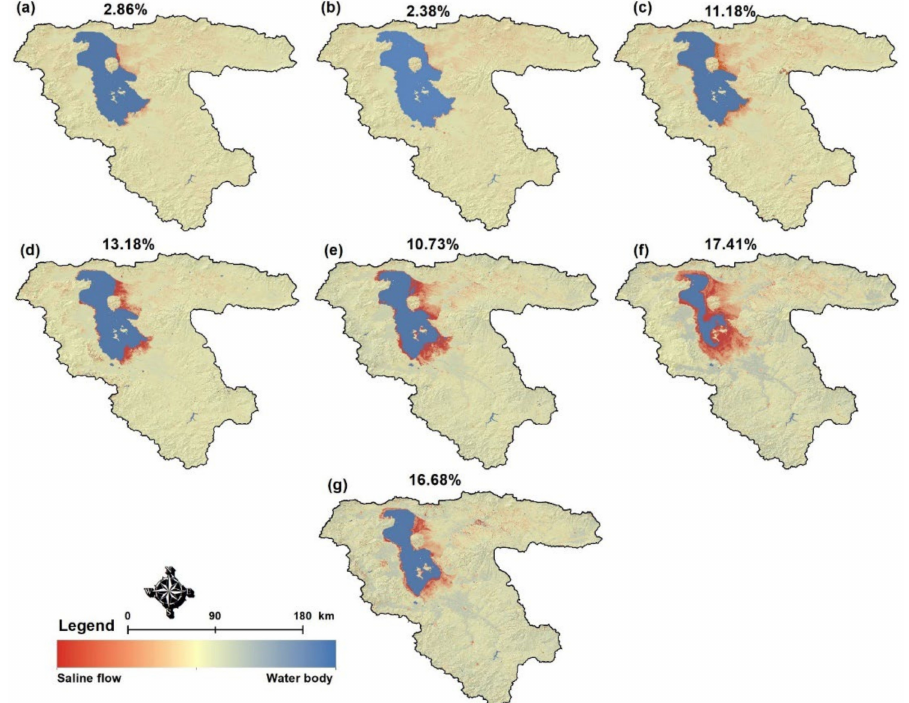
Figure 8. Soil salinity based on the CSRI index in: ( a ) 1990; ( b ) 1995; ( c ) 2000; ( d ) 2005; ( e ) 2010; ( f ) 2015; and ( g ) 2020. As can be seen on the maps, the soil salinity (red areas) has increased significantly from 1990 to